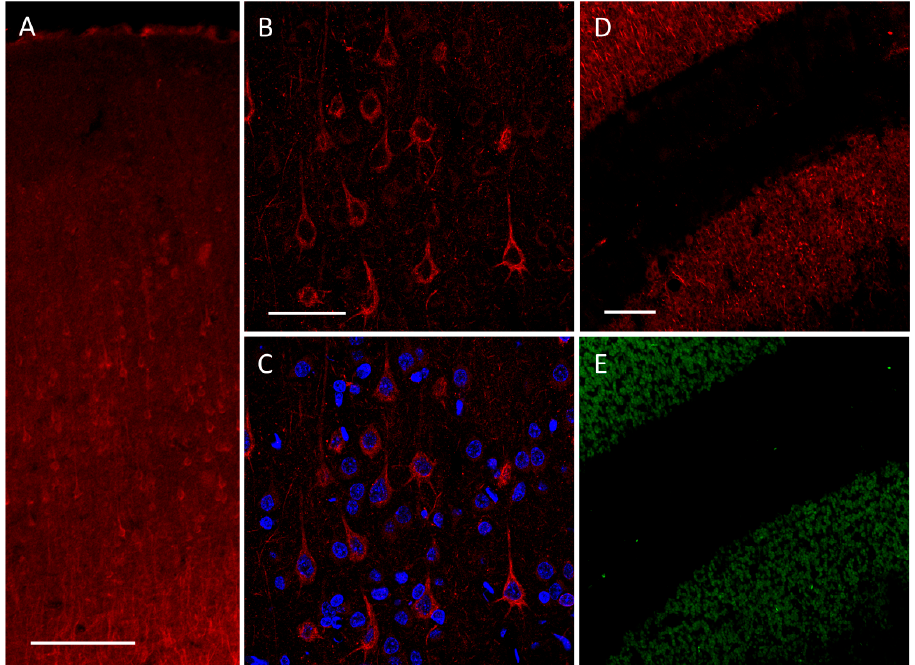
Figure 1. Immunofluorescent staining of TREK ‐ 2 performed on PFC. ( A ) The most prominent signal of potassium channel staining is localized in neurons, particularly in the V layer of PFC. ( B ) With higher magnification, the morphology of Trek2 ‐ positive neurons is evident: the shape of cells marked by a TREK ‐ 2 signal (red) is typical for pyramidal neurons. Trek2 is localized in the soma (and in protrusions). ( C ) DAPI (blue) staining reveals neuronal and non ‐ neuronal cell nuclei. ( D ) Control staining with immunosignal of TREK ‐ 2 and ( E ) immunosignal of NeuN in the cerebellum cortex. The latter is a marker of granular cells. The TREK ‐ 2 signal is localized in the granular layer with a molecular layer deprived of TREK ‐ 2 signals. Such a distribution stays in line with reports on KCNK10 transcript localization and with electrophysiological data [47,48]. Scales bars: ( A ) 200 μ m, ( B , C ) 50 μ m, and ( D , E ) 100 μ m.